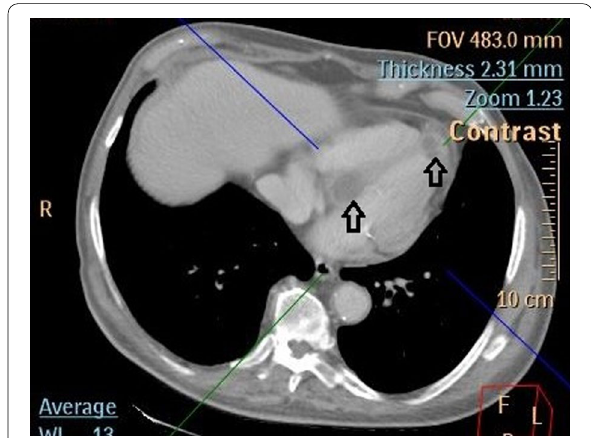
Fig. 1 Computerised Tomography identifying a 28 mm lesion at the apex of the left ventricle and another 40 mm lesion in the proximal interventricular wall (indicated by arrows)